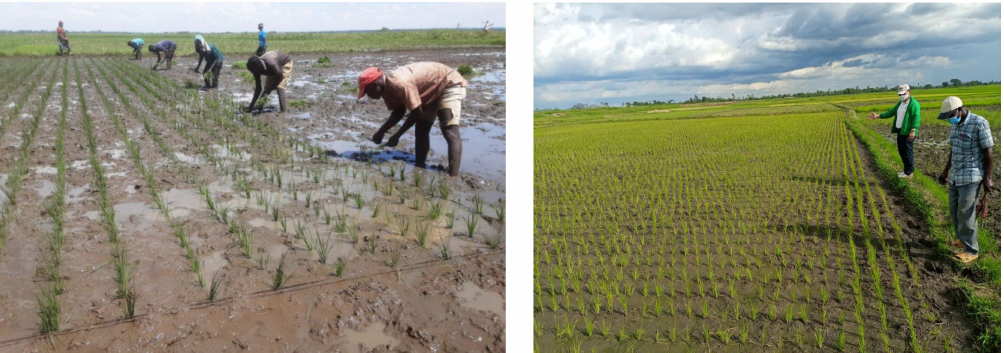
Figure 2. Demonstration and training of farmers on how to transplant rice in lines using a transplant- ing line adapted from